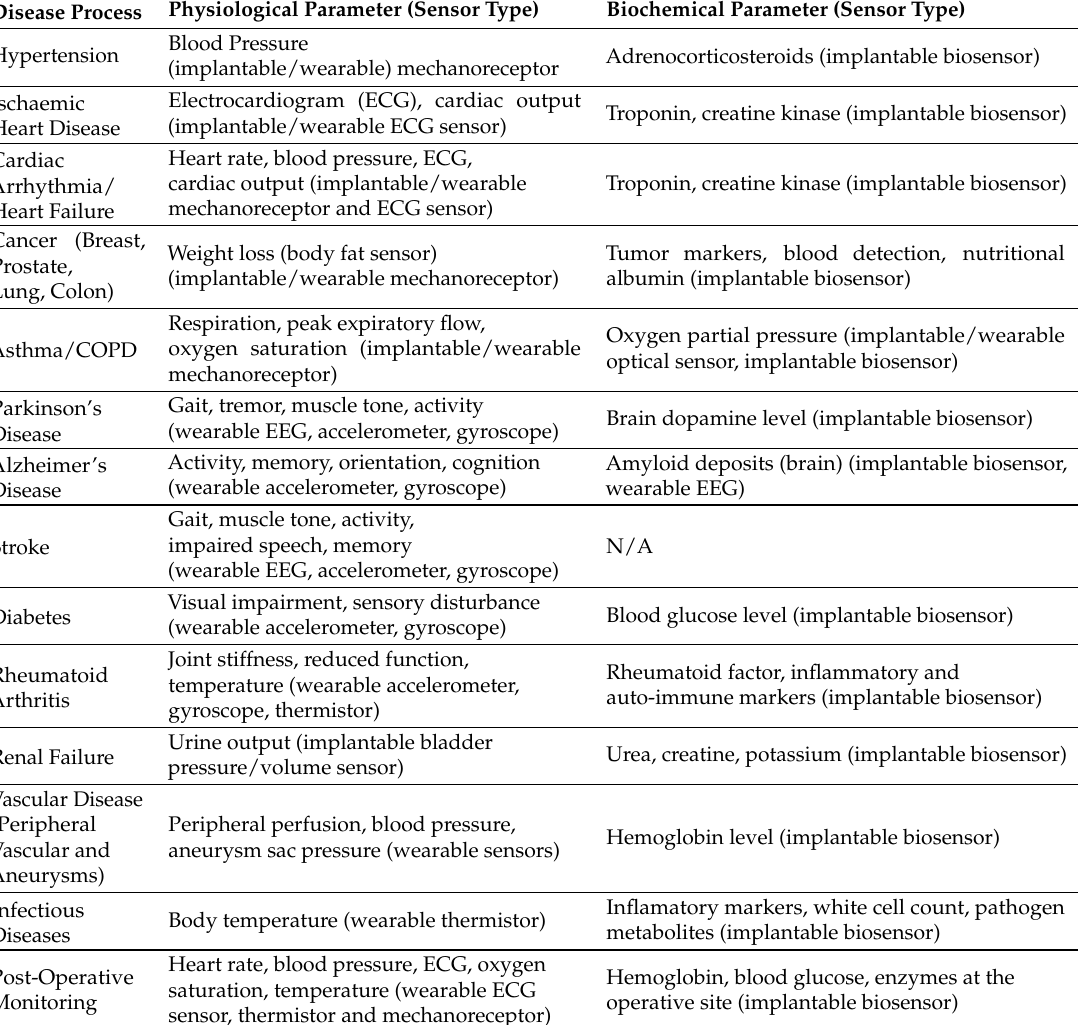
Table 3. Parameters to be monitored for different medical conditions. Inspired from